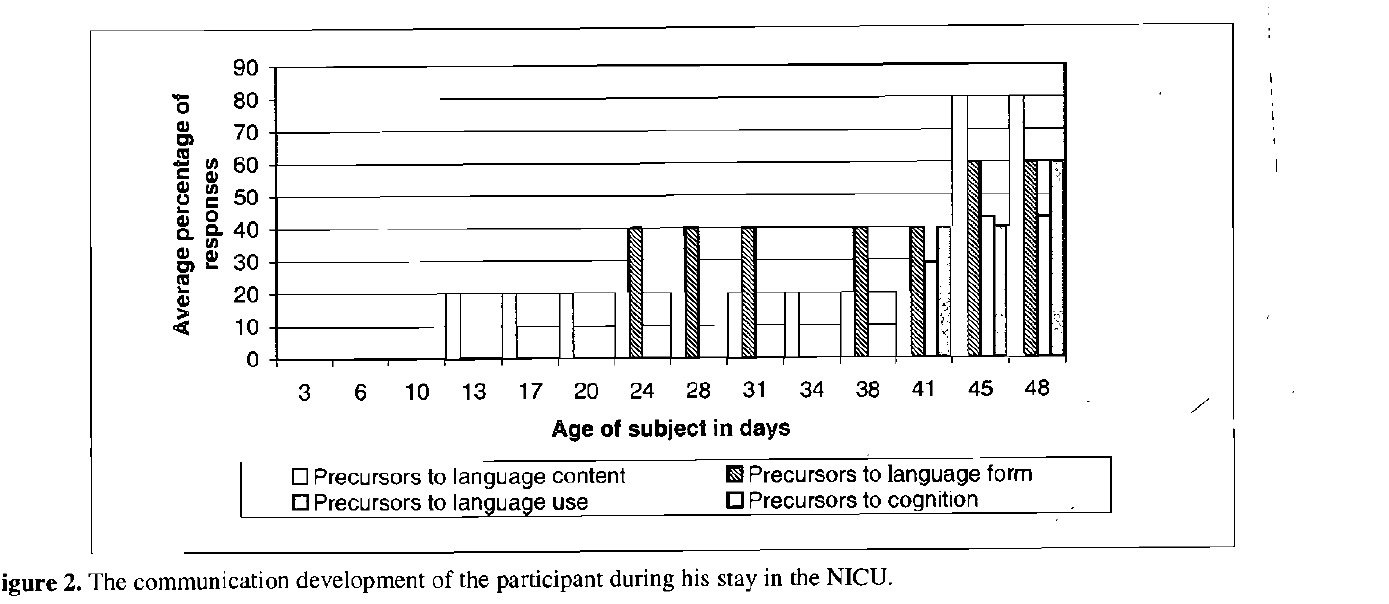
Figure 2. The communication development of the participant during his stay in the NICU. Die Suid-Afrikaanse Tydskrif vir